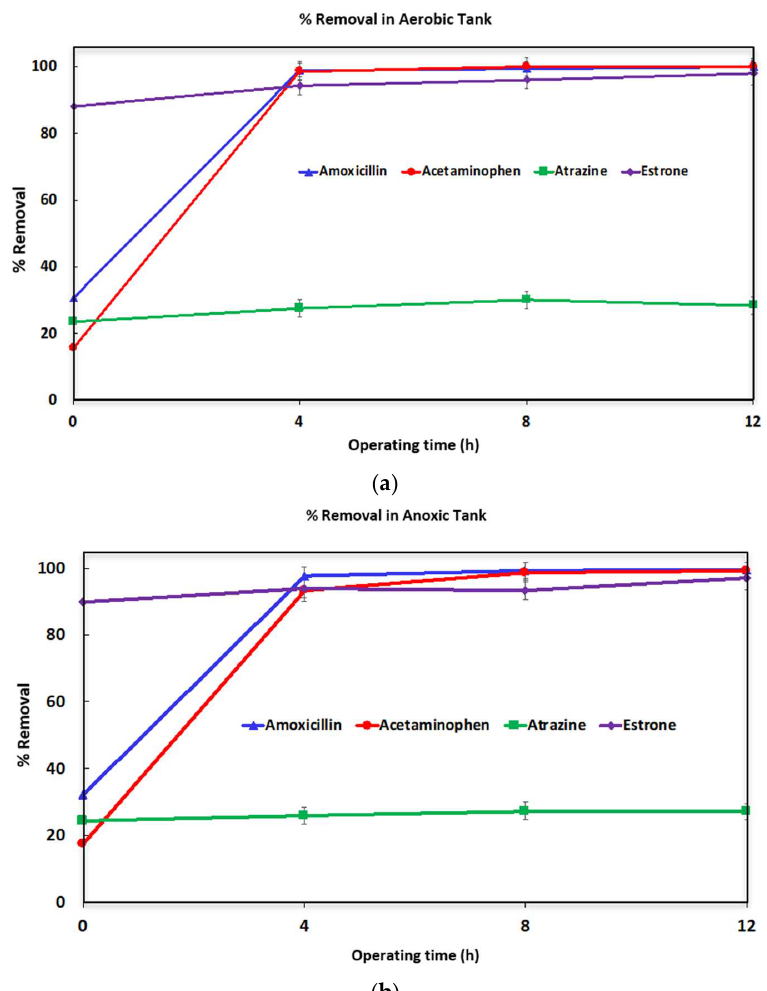
Figure 5. Percentage removal of the micropollutants in the aerobic ( a ) and anoxic ( b ) tanks as a function of operating time. Experiments were conducted at room temperature, 25 °C.